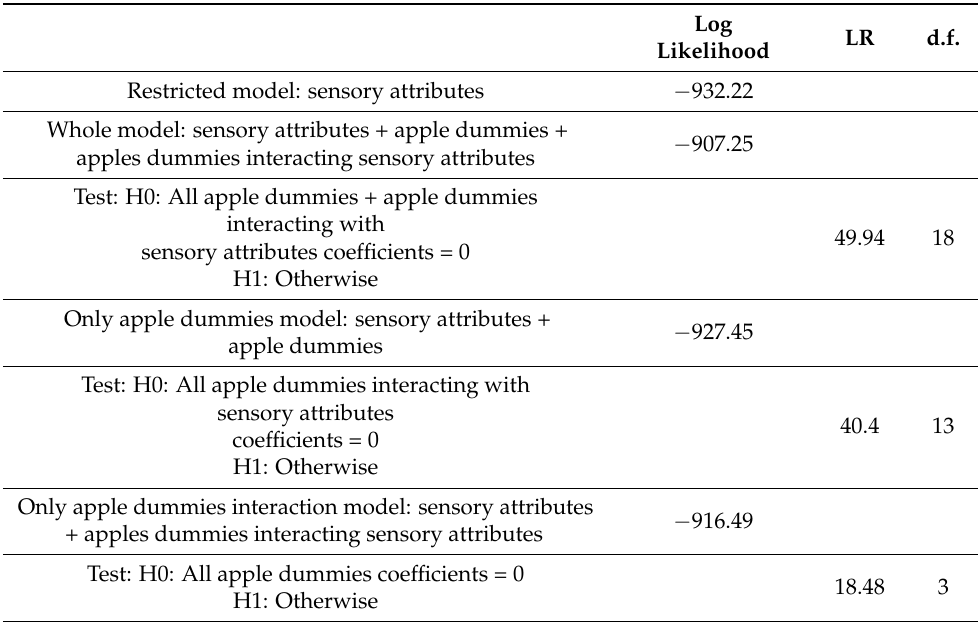
Table 3. Likelihood Ratio test for testing whether the effect of the sensory attributes on the WTP is different among apple varieties and growing